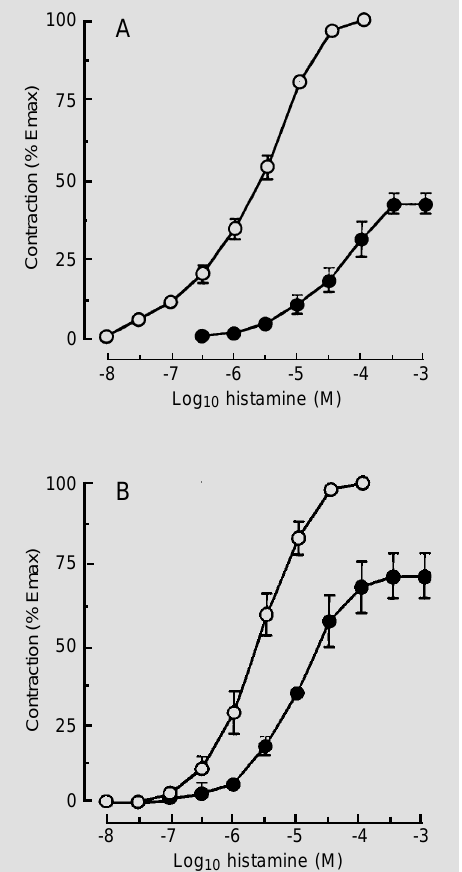
Figure 1 - Concentration-effect curves for histamine in the ab- sence (open circles) or presence (closed circles) of L-arginine (100 mM) (A) or D-arginine (100 mM) (B) in guinea-pig isolated tra- chea. Each point represents the mean of 4-6 observations and vertical bars represent the SEM. Indomethacin (5 µM) is present throughout.